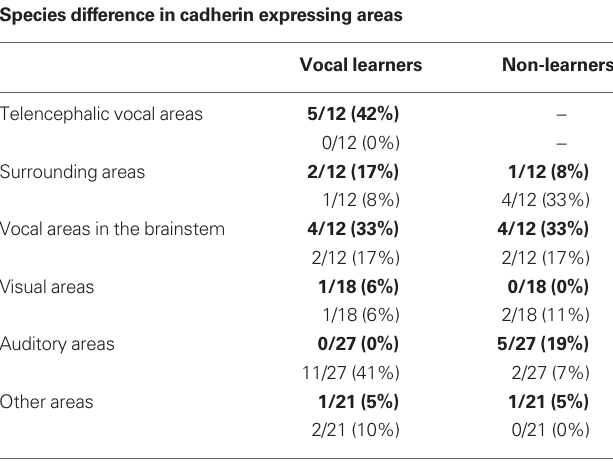
Table 2 | Summary of species difference in cadherin expressing